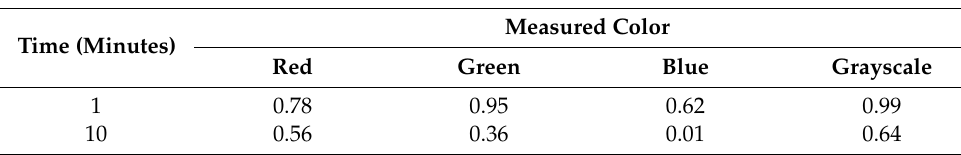
Table 2. R 2 values for the exponential regression models for mean color values based on the nat- ural log of melatonin concentrations. Sorted by the measured color and the time at which the measurements were taken after the Congo Red Dye was added. Values were calculated using Excel. R 2 Values for Color Value vs. ln(Melatonin Concentration) Measured Color Time (Minutes) Red Green Blue